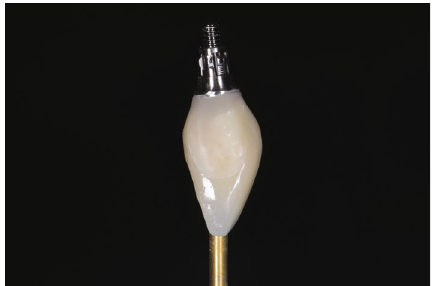
Figure 8: Buccal socket grafting with the last used drill placed in the implant site.